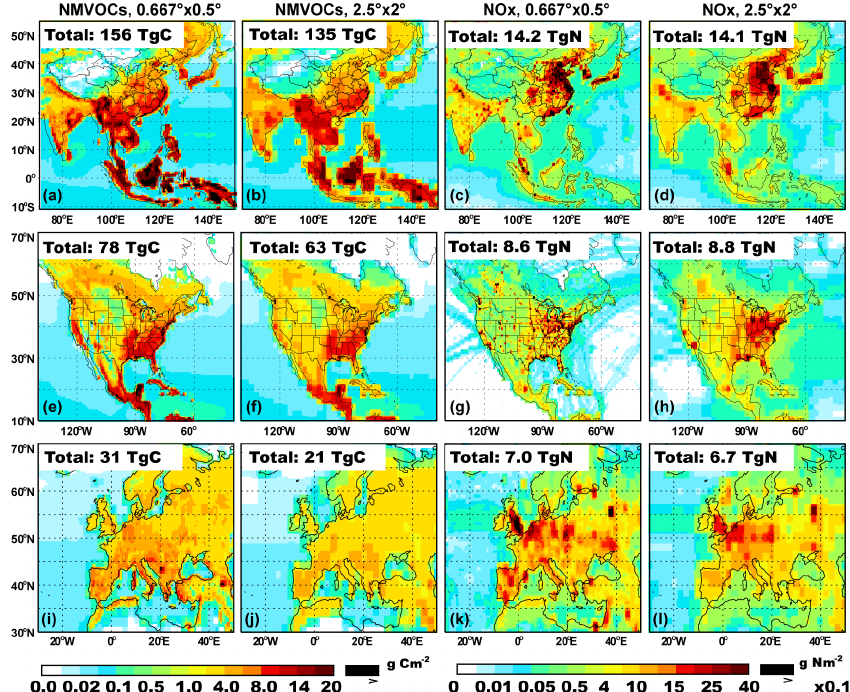
Figure 2. Total (anthropogenic + natural) emissions of NMVOCs and NO x over Asia, North America and Europe in 2009, as represented in the nested models (0.667 ◦ × 0.5 ◦ ) and the global model (2.5 ◦ × 2 ◦ ). Values outside the upper bound of color intervals are shown in black. Color intervals are nonlinear to better present the data range; an interval without labeling represents the mean of adjacent two intervals. Also depicted in each panel is the regional